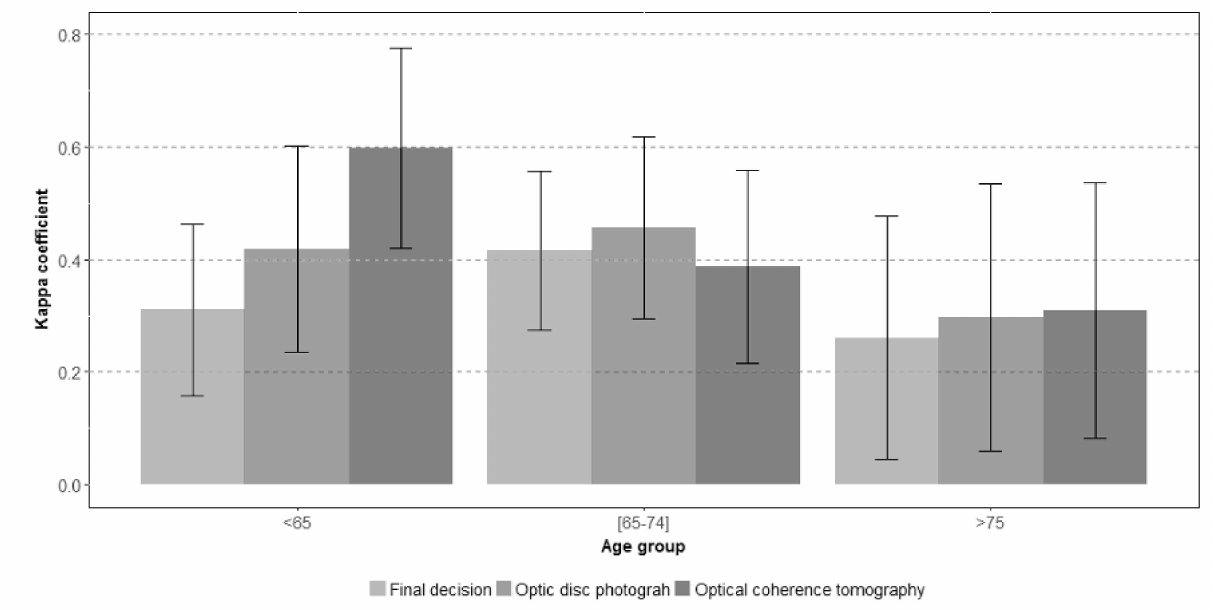
Figure 3. Interobserver agreement between expert and non-expert evaluators in each age group. The y axis depicts the kappa coefficient estimates and their respective confidence intervals. The x -axis shows the three age groups: under 65 years, 65 to 74 years, and over 74 years. Kappa values are highest on evaluation of OCT images from the youngest participants and decrease with increasing age. The lowest agreement values were found within the oldest group of participants for overall, OCT and photograph